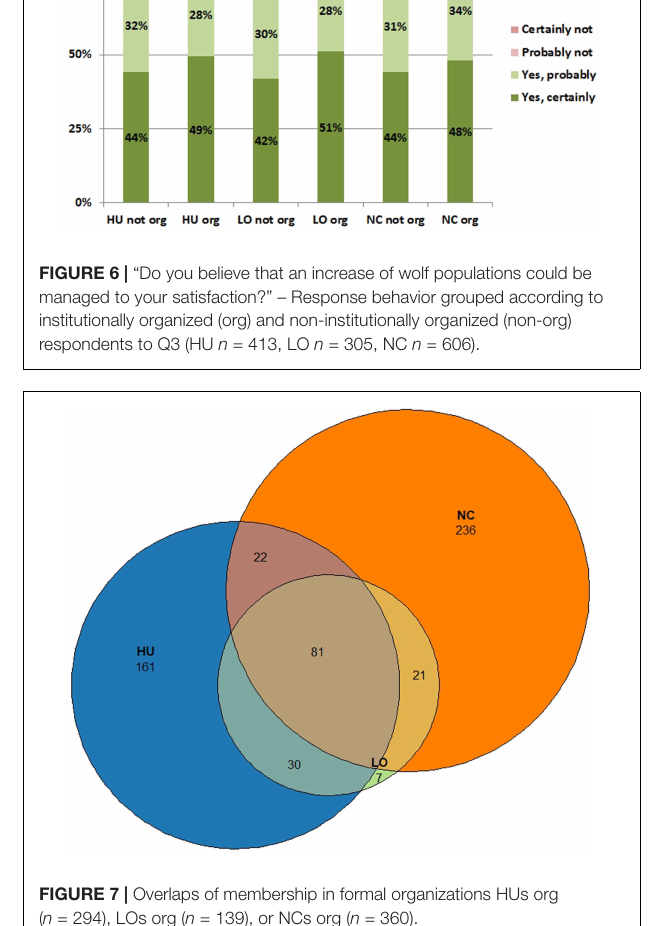
categories. 14.5% ( n = 81) are even members of organizations